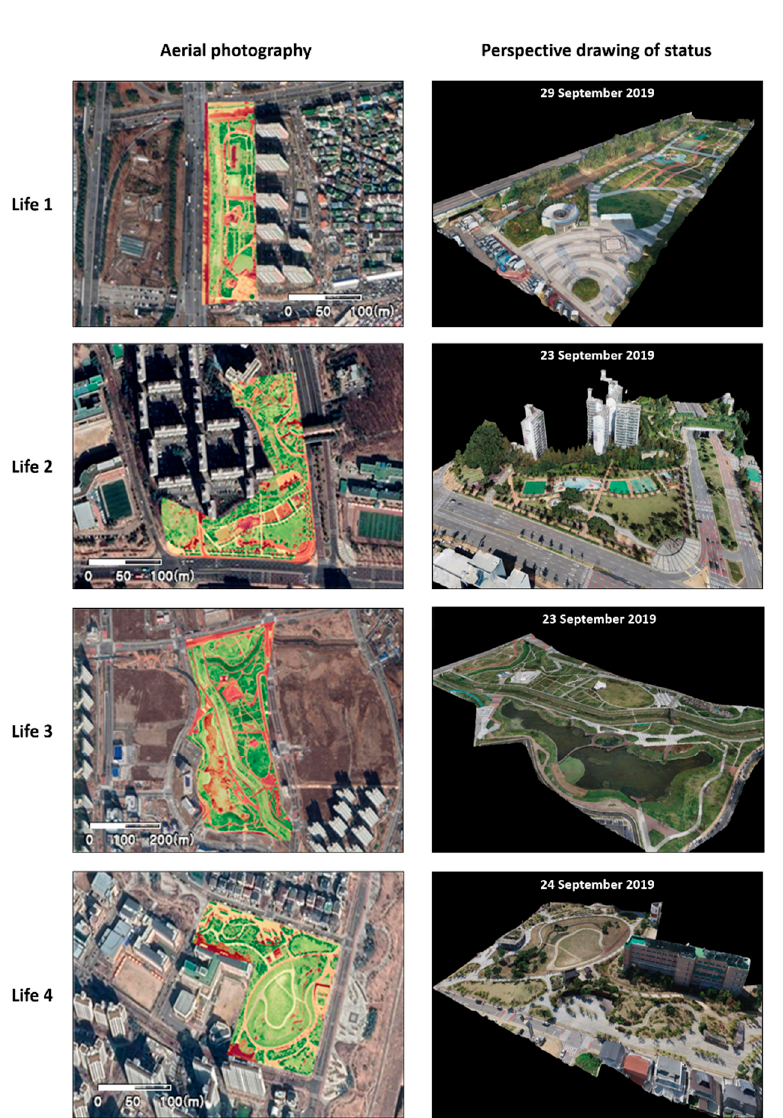
Figure 3. Photos of the land cover status of the living zones-4 study sites.